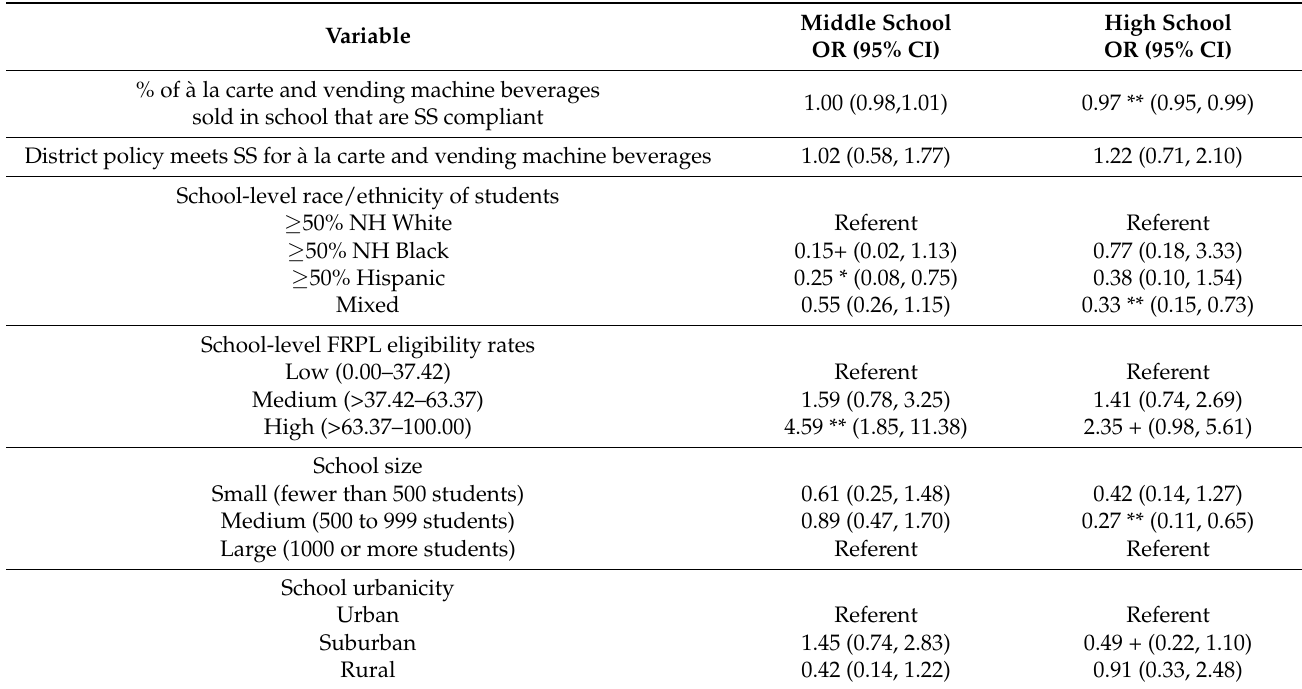
Table A1. Logistic regression results predicting student consumption of Smart Snacks non-compliant beverages at the 10 kcal threshold by school